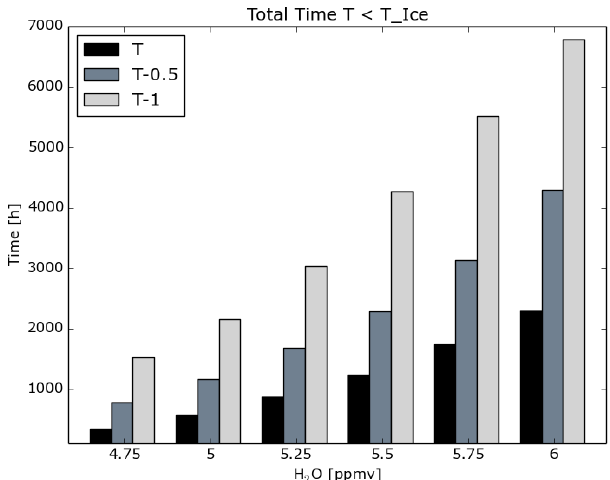
Figure 9. Histogram of total time where the temperature along the back trajectory is below the ice formation threshold temperature (sum over all 738 back trajectories) for a stratospheric H 2 O increase of 4.75, 5.0, 5.25, 5.5, 5.75 and 6.0ppmv.